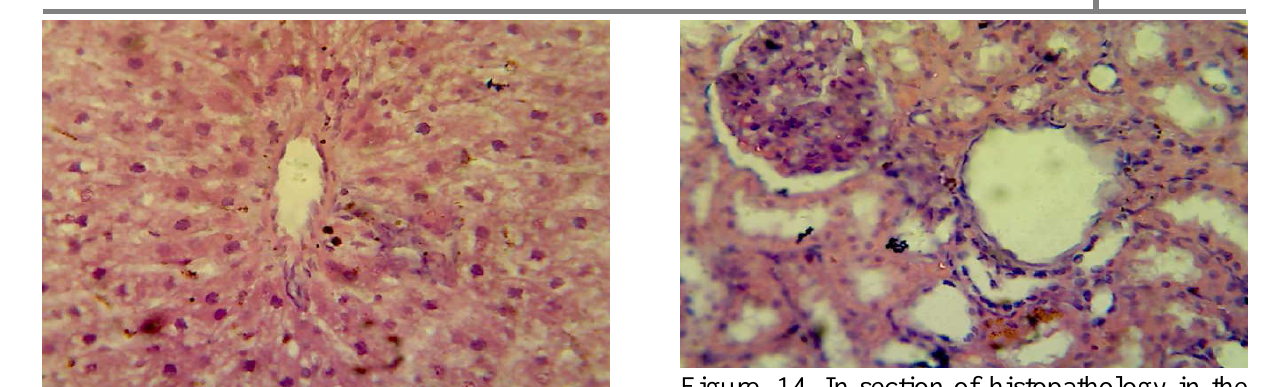
Figure, 14. In section of histopathology in the kidney of rat receiving 1mg/kg B.W. of acrylamide for 65 days in (G3 group): showed acute cellular degeneration, disappear of glomerular tufts left dilated Bowman space (H.& E.stain 400X).